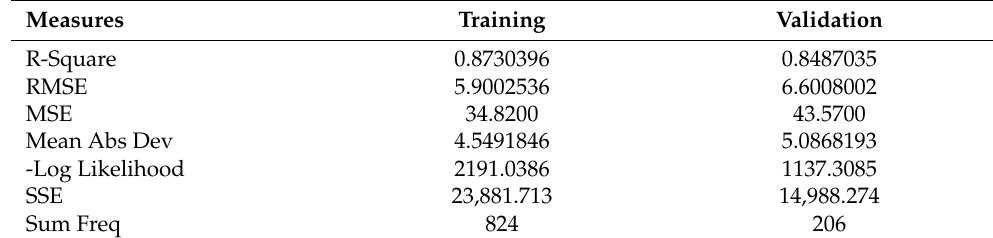
Table 3. Predicted Statistical Measures with Both Training and Validation Values.